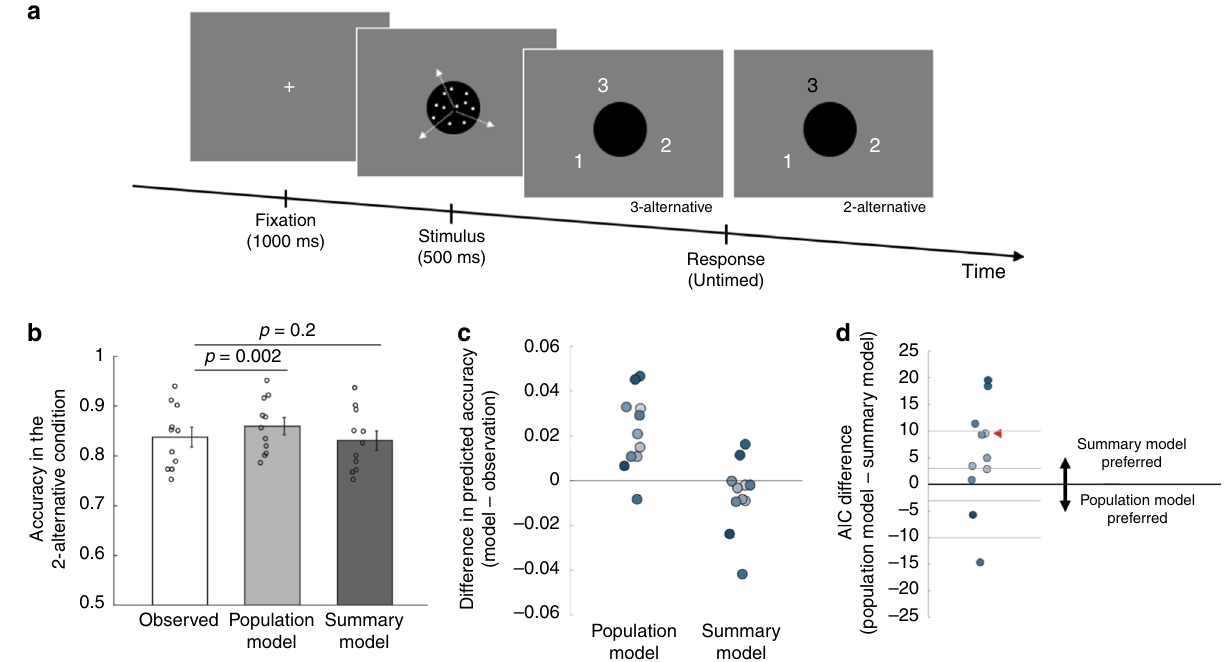
Fig. 7 Task and results for Experiment 4 which uses stimuli on a continuous scale. a Three sets of dots moved in three different directions separated by 120°. Similar to Experiments 1 – 3, one of the three sets of dots had more dots (i.e., dominant direction) compared to the other two sets (i.e., nondominant directions). Each trial began with a fi xation cross followed by the moving dot stimulus presented for 500 ms. The response screen was presented immediately after the offset of the moving dots and randomly assigned a stimulus-response mapping on each trial. Similar to Experiments 1 and 2, subjects picked the dominant direction of motion between all three directions (three-alternative condition) or between the dominant direction and one randomly chosen nondominant direction (two-alternative condition). b Mean accuracy in the two-alternative condition observed in the actual data (white bar) and predicted by the population (light gray bar) and summary (dark gray bar) models. The predictions for both models were derived based on the data in the three-alternative condition. All p values are derived from two-sided paired t tests. Error bars represent SEM, n = 11. c Individual subjects ’ differences in the accuracy of the two-alternative condition between the predictions of each of the two models and the observed data. d AIC difference between the population and summary models. Positive AIC values indicate that the summary model predicts the observed data better. The red triangle indicates the average AIC difference. The summary model fi ts better than the population model for nine out of the 11